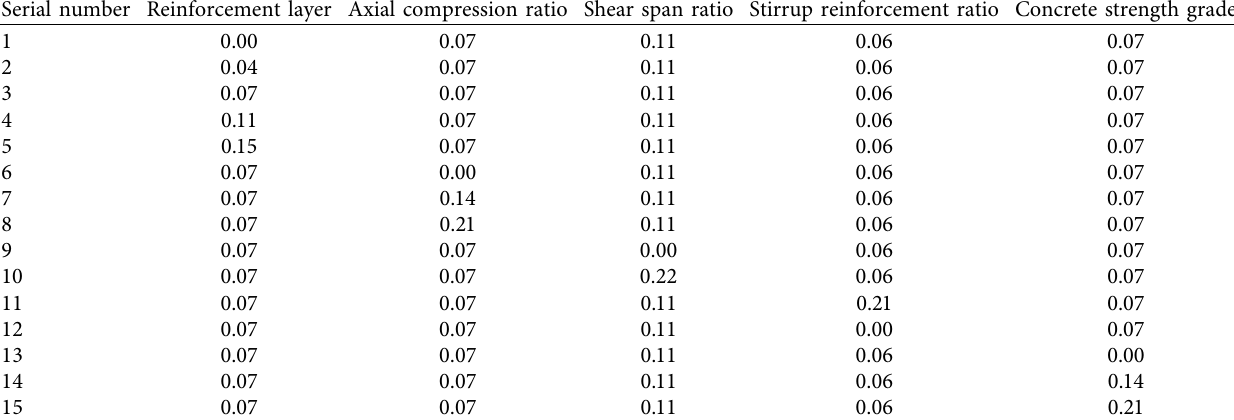
Table 6: Sample input sample data.